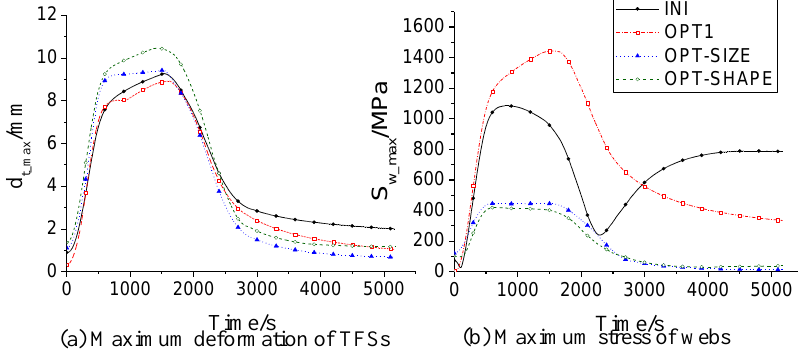
Figure 15. ( a ) Temperature along the path on bottom surface. ( b ) INI, ( c ) OPT1, ( d ) OPT-SIZE and ( e ) OPT-SHAPE. The paths are marked by arrow lines.